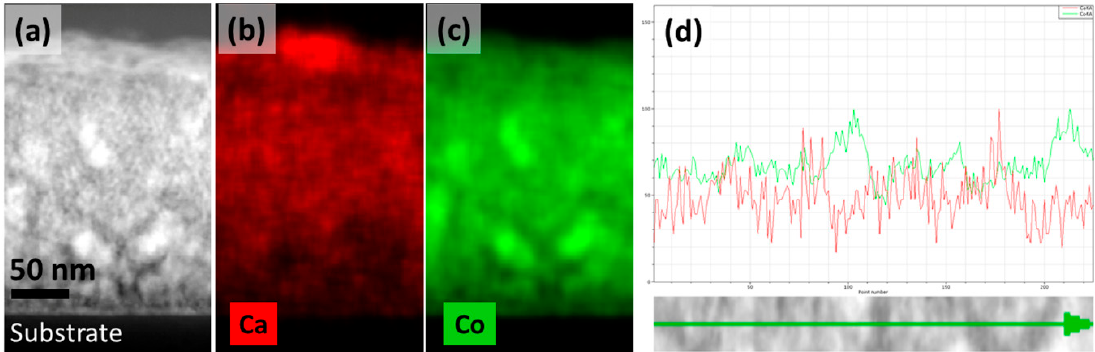
Figure 4. ( a ) TEM image of as-deposited CaO–CoO film, ( b , c ) EDS mapping of the corresponding film, ( d ) line scan along in-plane direction of the film; green line represents Co and red line Ca.